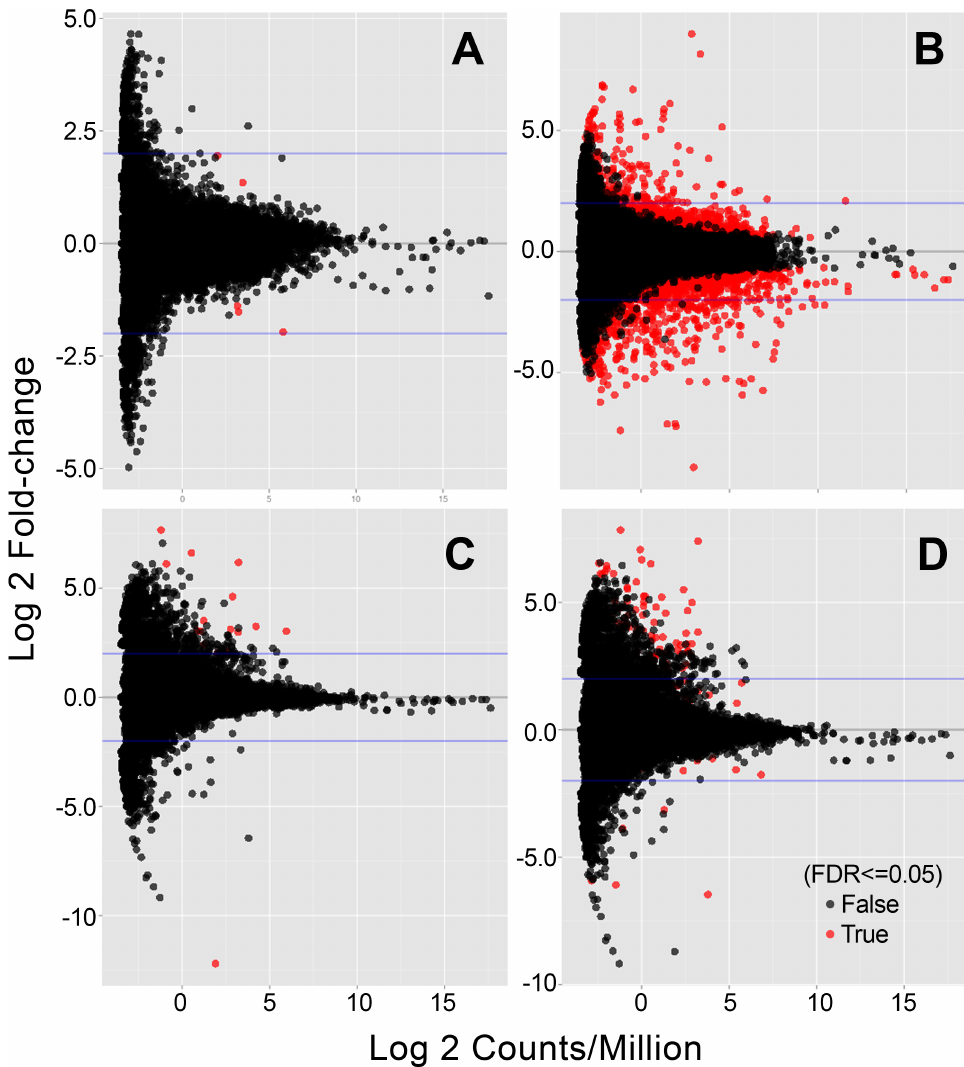
Fig 1. MA plots for genes that were altered in lenses obtained from Cryaa -R49C or Cryab- R120G mutant knock-in mice as compared with age-matched WT mice. (A) 2-day-old Cryaa -R49C-het, (B) 2-day-old Cryaa -R49C-homo, (C) 14-day-old Cryab -R120G-het, and (D) 14-day-old Cryab -R120G-homomice. The x-axis indicates the averageexpressionover all samples in the Cryaa (or Cryab ) lenses. The y-axis represents the log 2-fold change of normalized counts betweenthe mutant and WT